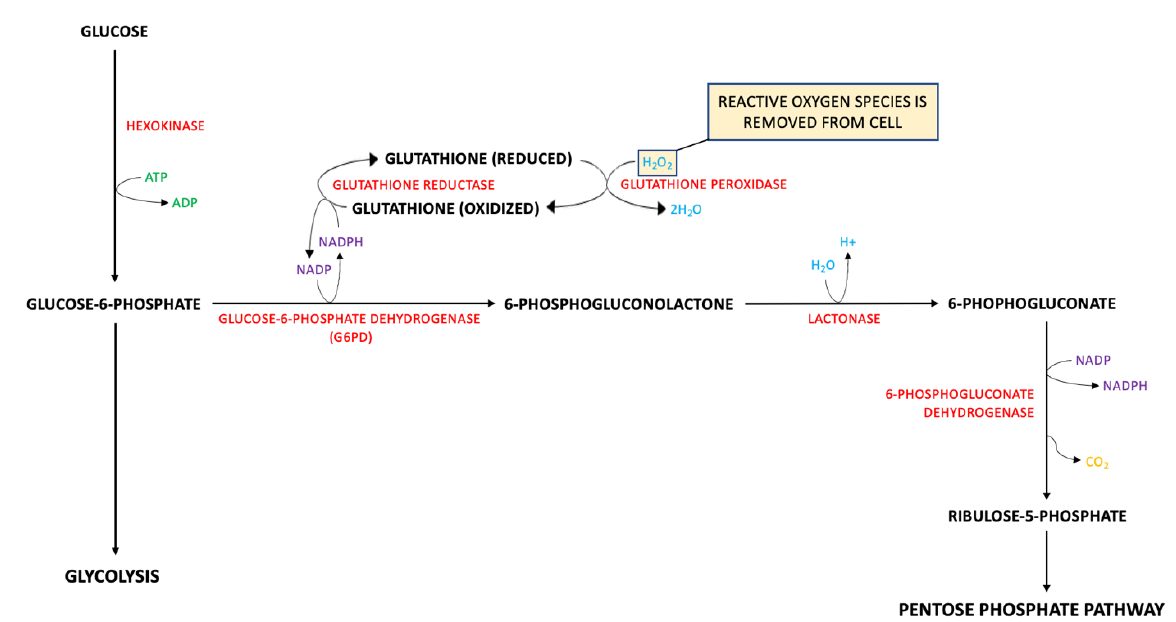
Figure 38. The Pentose Phosphate Pathway is protective for the BBB.